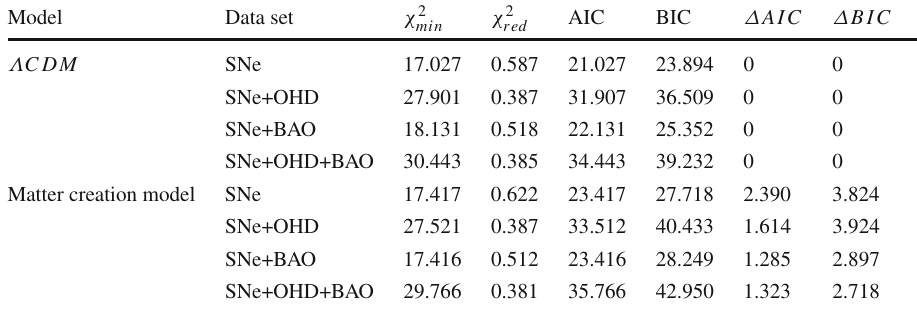
Table 3 Summary of the reduced χ 2 , Δ AIC and red Δ BIC for Λ CDM model and matter creation